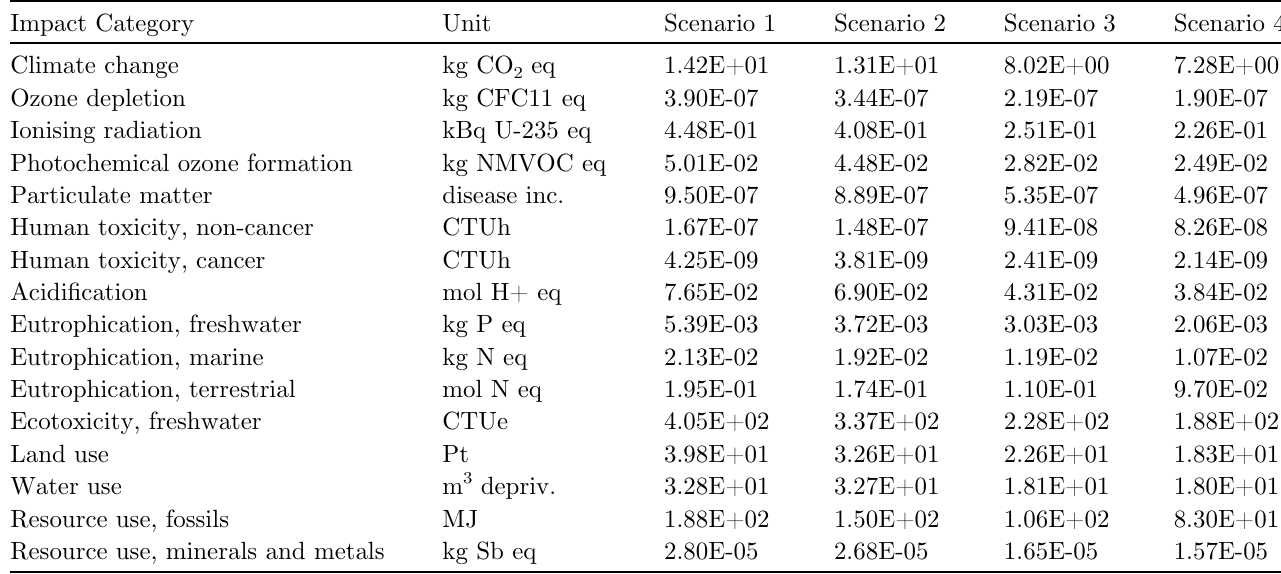
Table B1. Characterization results per scenario. LCIA method: EF 3.0. Functional Unit = 1